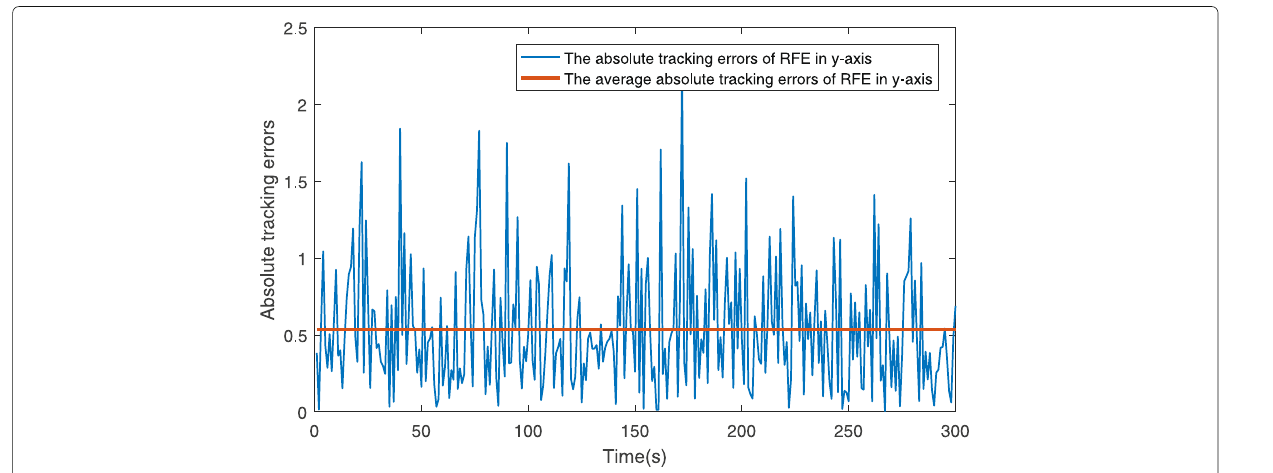
Fig. 21 The absolute tracking errors of RFE in y -axis with varied cross-correlation